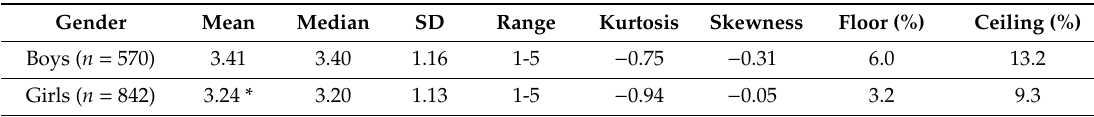
Table 1. Descriptive statistics of the Lithuanian Body Appreciation Scale-2 (the adolescent sample, n =